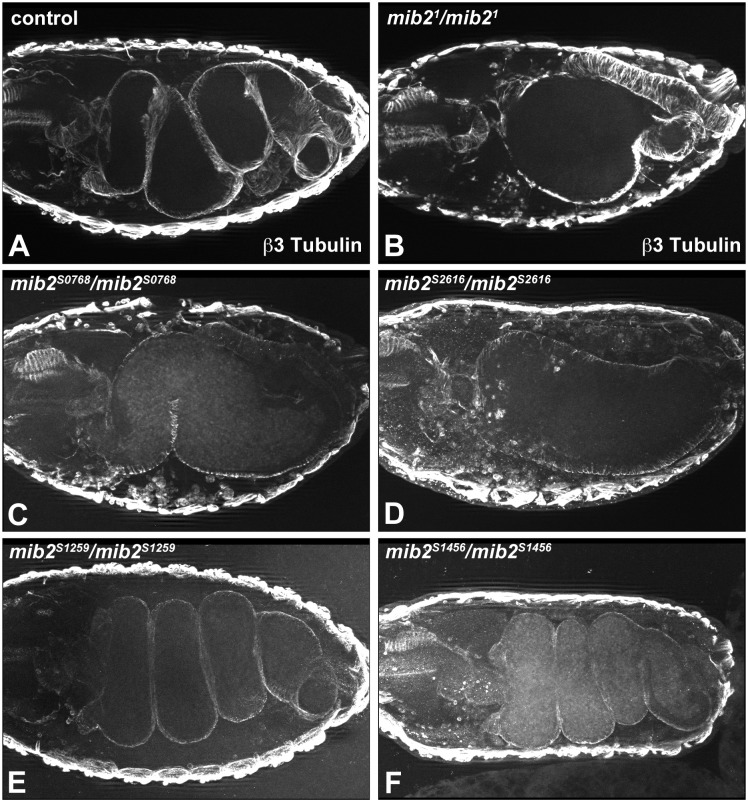
mib2S0768 and mib2S2616 mutant embryos exhibit abnormal midgut development.Late stage 16 embryos were stained with an antibody against β3-Tubulin. In contrast to the control embryo (A), homozygous mib21 (B), mib2S0768 (C), and mib2S2616 (D) mutant embryos show a “bloated” midgut with abnormal constrictions. Normal constriction and morphogenesis are however observed in homozygous mib2S1259 (F) and mib2S1456 (G) mutant embryos.